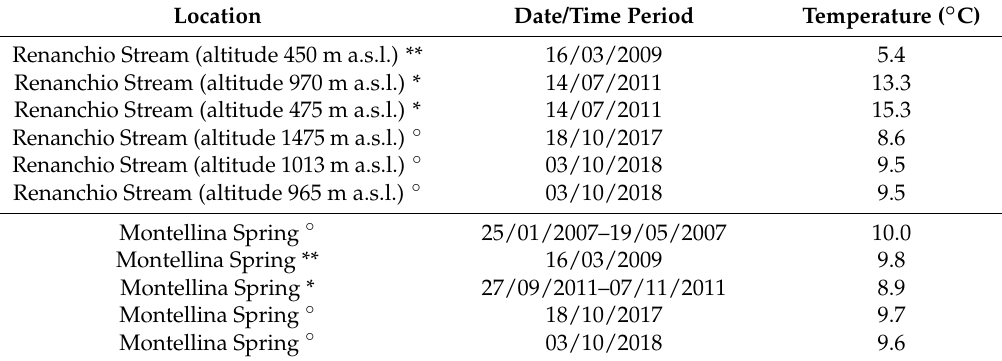
Table 3. Temperature data referred to Montellina Spring and Renanchio Stream: ** measures from [14], * measures conducted during the tracer tests, and ◦ data from our other research. Data are related to punctual temperature measures, and measures conducted at time intervals (registered with a